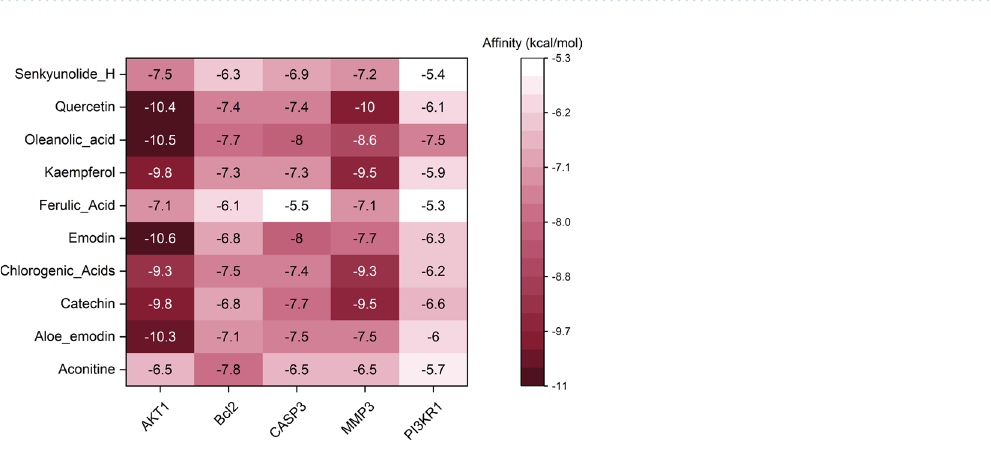
Figure 5. Enrichment analysis of targets of WFEA against lung adenocarcinoma. ( A ) biological process, ( B ) molecular function, ( C ) cell composition and ( D ) signaling pathway.